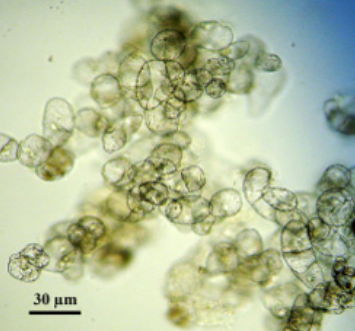
Figure 1. Left—Growth curves of the suspension cell culture of Taxus baccata lines Tb-msu/ В 5-PB- pv p ( В 5PBpvp-f in the legend) and Tb-msu/ В 5-NB ( В 5NB-f ) during cultivation in flasks and line Tb-msu/ В 5-NB during cultivation in 20-l bioreactor ( В 5NB-b) under semi-continuous regime (the third cycle of cultivation). Right—photograph of cell suspension cultures in 250-mL flasks and microphotograph of cells of Tb-msu/ В 5-NB line Table 2. Growth characteristics of the suspension cell cultures of Taxus baccata grown in 250-mL flasks and 20-l bioreactors.